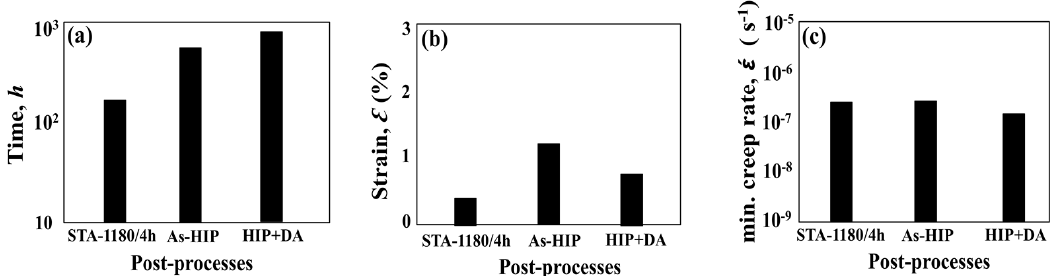
Figure 13. ( a ) Creep life, ( b ) creep rupture elongation, and ( c ) the minimum creep rate of post-processed specimens under 650 °C/550 MPa.